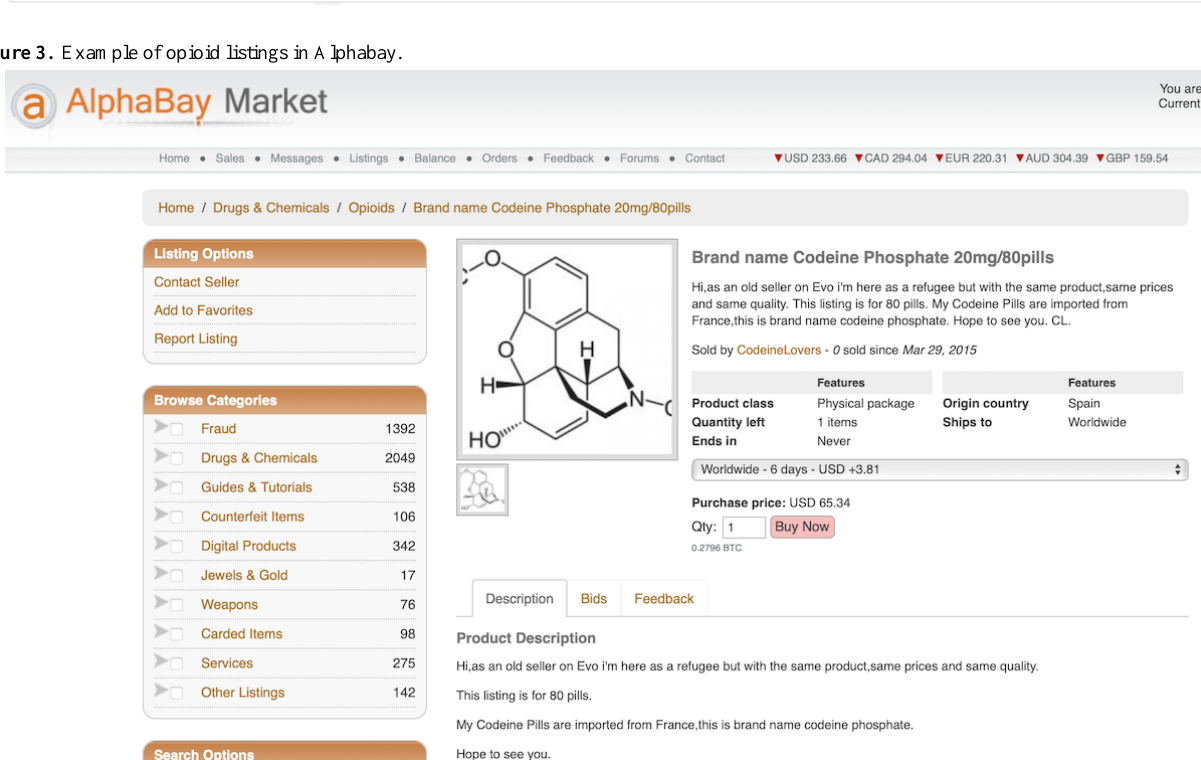
Figure 3. Example of opioid listings in